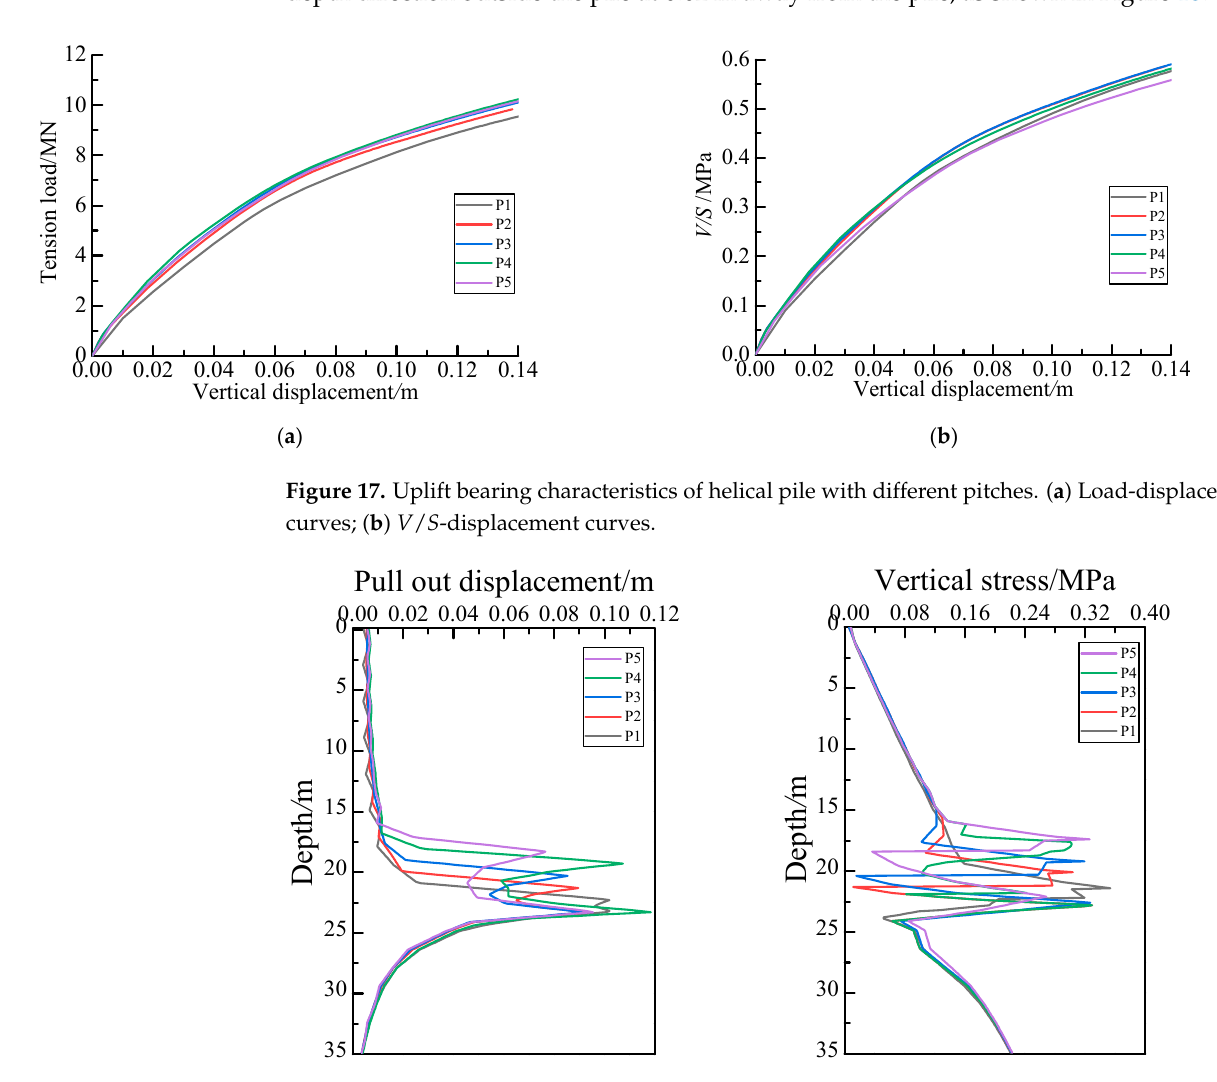
Figure 18. Displacement and stress distribution of soil outside pile along the depth direction. ( a ) P2; ( b ) P3.